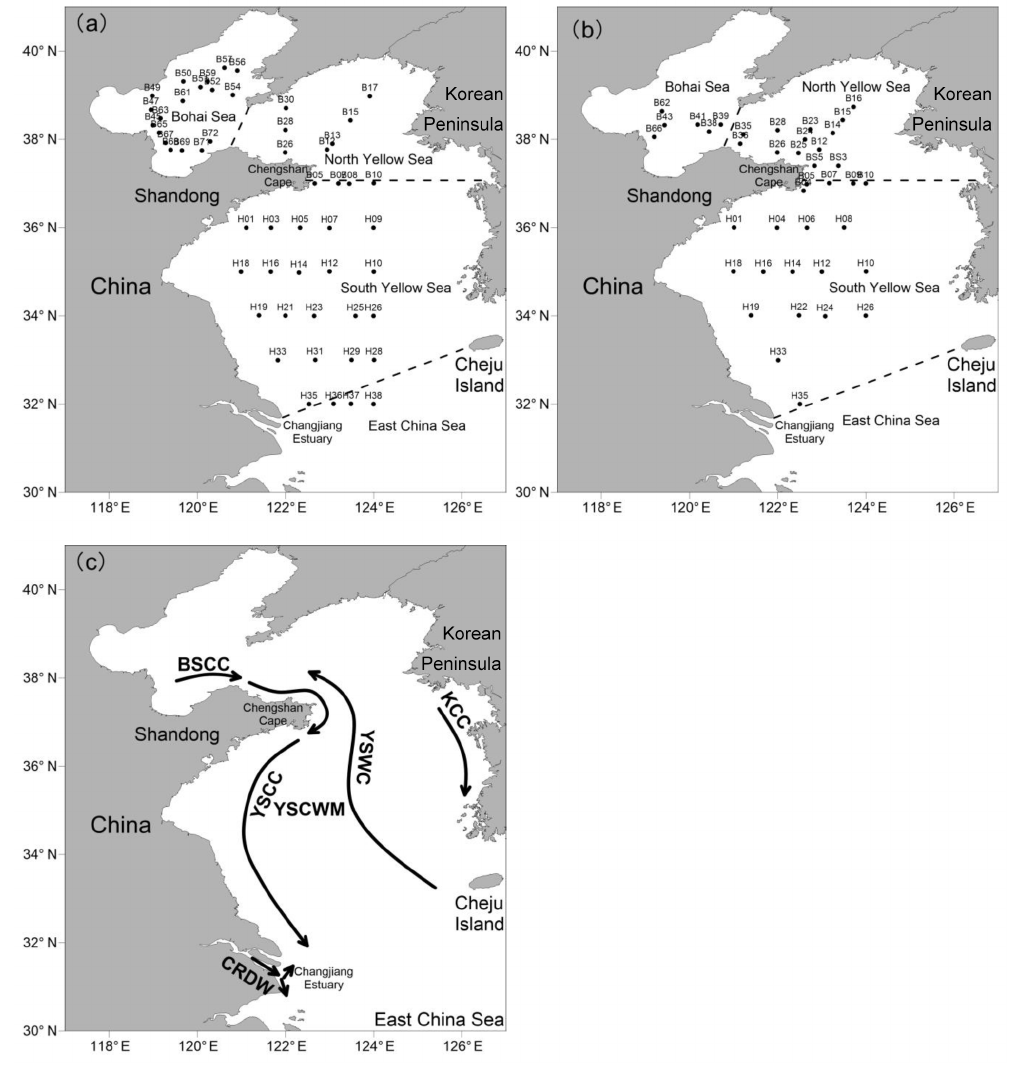
Figure 1. Locations of the sampling stations in the BS and YS during summer (a) and winter (b) . (c) Schematic circulations and water masses in the BS and YS (Su, 1998; Lee et al., 2000). BSCC: Bohai Sea Coastal Current; YSCC: Yellow Sea Coastal Current; KCC: Korea Coastal Current; YSWC: Yellow Sea Warm Current; CRDW: Changjiang River Diluted Water; YSCWM: Yellow Sea Cold Water